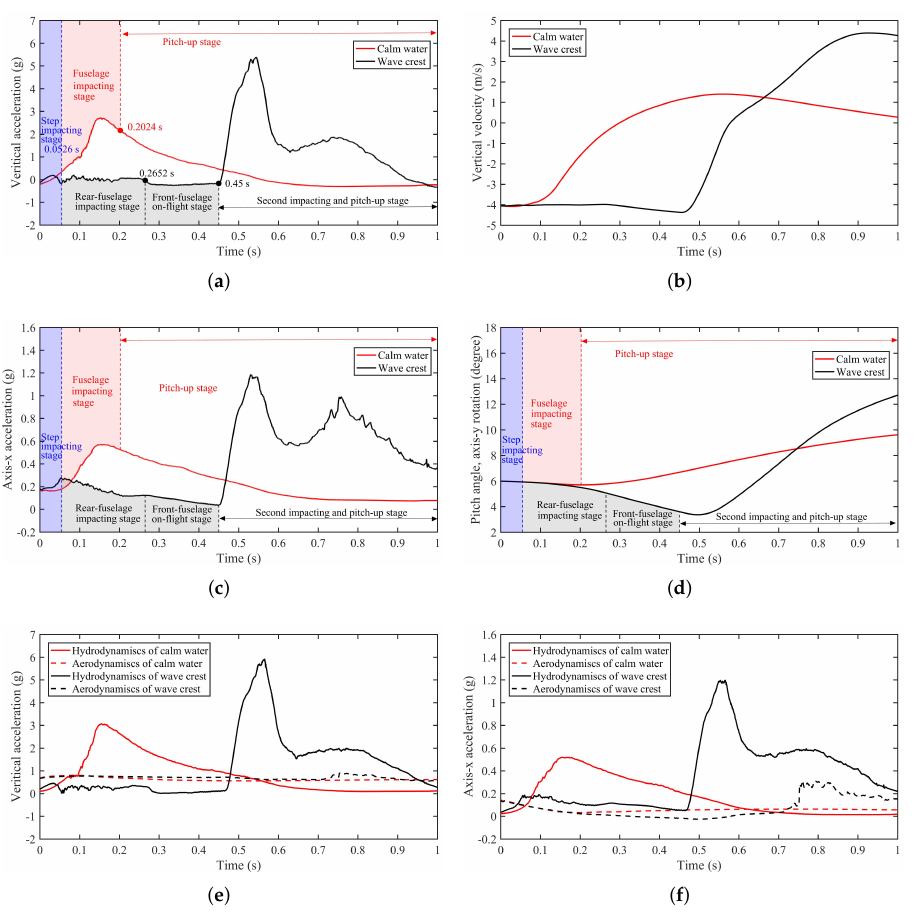
Figure 8. Comparison of time–history results between calm water and wave crest aircraft landing simulation: ( a ) vertical acceleration; ( b ) vertical velocity; ( c ) axis-x acceleration; ( d ) axis-y rotation, pitch angle; ( e ) vertical acceleration by the hydrodynamics and aerodynamics; ( f ) axis-x acceleration by the hydrodynamics and